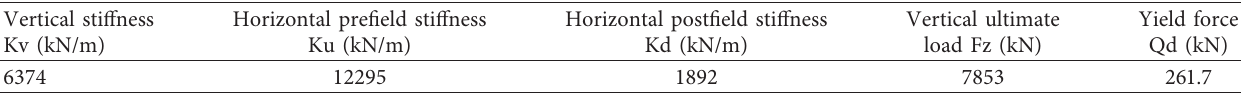
Table 1: Main mechanical parameters of